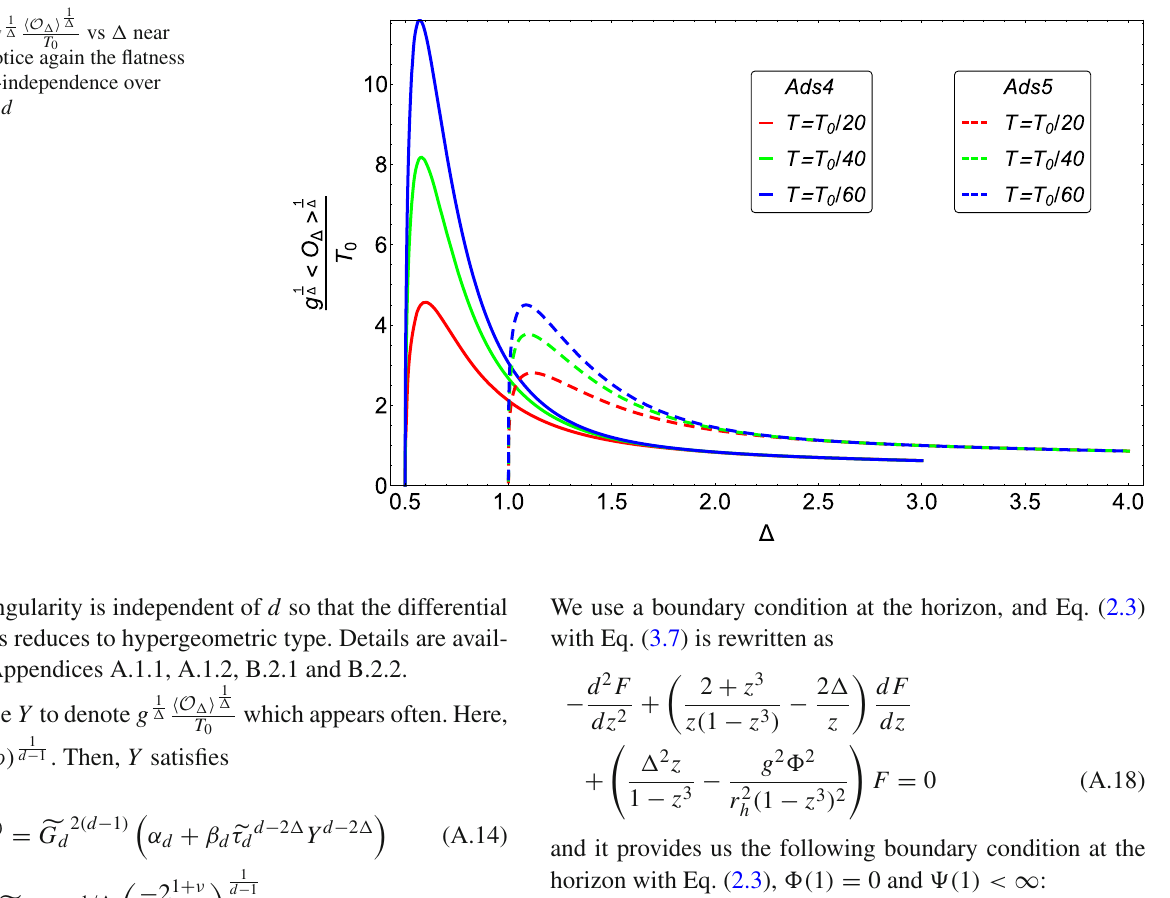
Fig. 13 g 1 (cid:2) (cid:3) O (cid:2) (cid:4) T = 0. Notice again the flatness and the T -independence over d < (cid:2) < 2